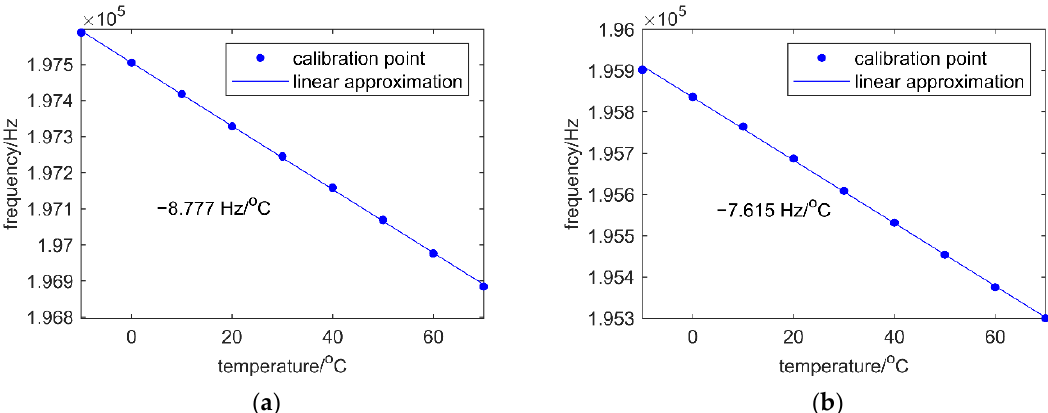
Figure 6. ( a ) Calibration of temperature factor for resonator 1. ( b ) Calibration of temperature factor for resonator 2.